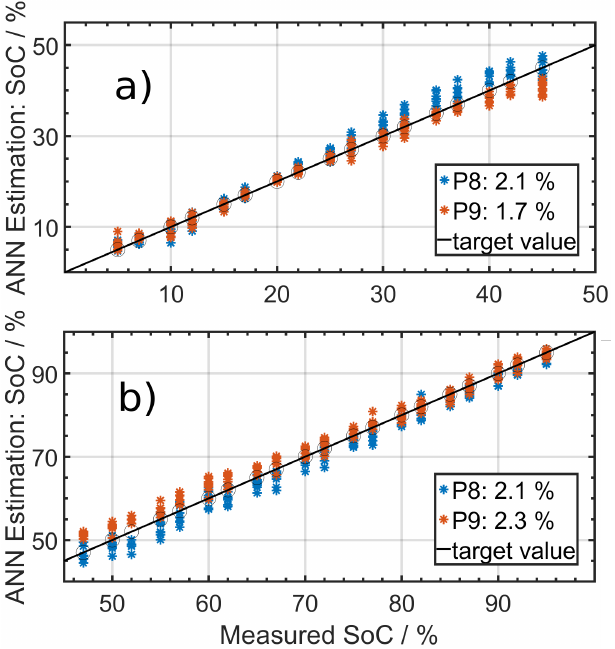
Figure 10. SoC estimation for Panasonic NCA 103450 cells with an RMSE of about 2%. The SoC was split into ( a ) 5% to 45% and ( b ) 47% to 95% and estimated by individual neural networks. Overall, almost 600 SoC estimations are shown. The estimated SoC is plotted over the measured SoC. The black line is a guide to the eye of the target values. The legend shows the RMSE for each cell.